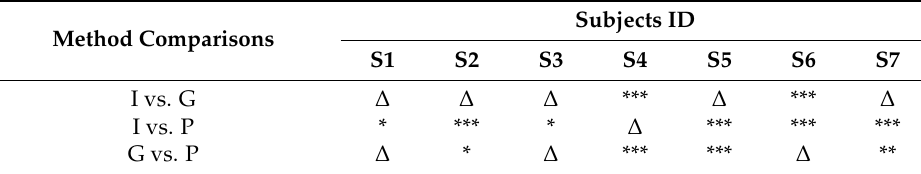
Table 2. Statistical analysis of the recognition rate for